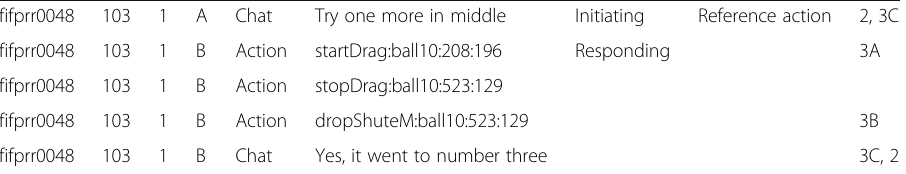
Table 4 Example of coded log data accompanied with identified gaze behaviour in accordance with areas of interest